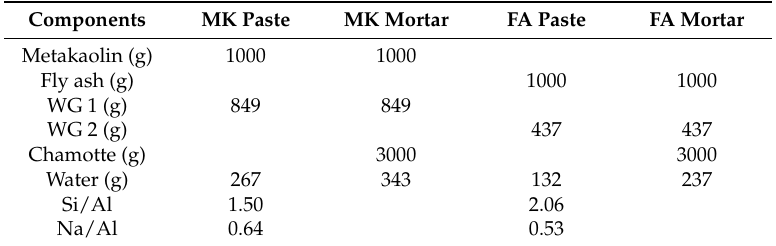
Table 2. Mix proportions of metakaolin/fly ash geopolymer paste and mortar and Si/Al and Na/Al ratios in the corresponding geopolymer mixture.